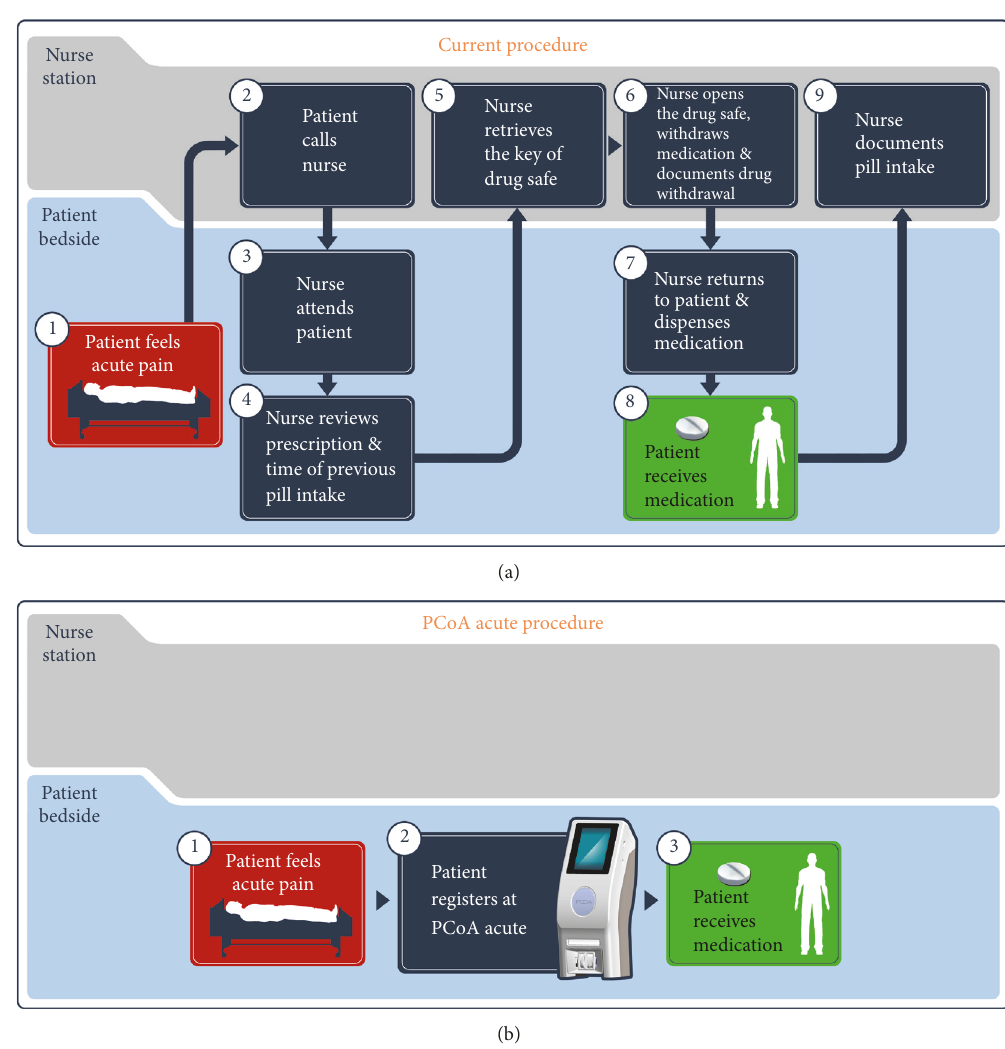
Figure 2: Comparison of pill provision processes evaluated in the study. (a) Current procedure involves the following steps. The patient feels acute pain (1). The patient calls the nurse (2) and waits until the nurse’s attendance (3). The nurse reviews the patient’s prescription and time of previous drug intake (4). Once new pain medication intake is approved, the nurse goes to the nurse station and retrieves the drug safe key (5). The nurse opens the drug safe, dispenses the medication, and documents drug withdrawal (6). The nurse returns to the patient’s bedside and provides the medication (7). Only then the patient receives the medication (8) and the nurse documents pill intake in the patient’s record file, located at the nurse station (9). (b) PCoA Acute process. The device is located near the patient’s bedside and the procedure comprises only 3 steps: the patient feels acute pain (1). He is registered at the device (by the RFID wristband) (2) and can immediately receive his medication, subject to therapy restrictions